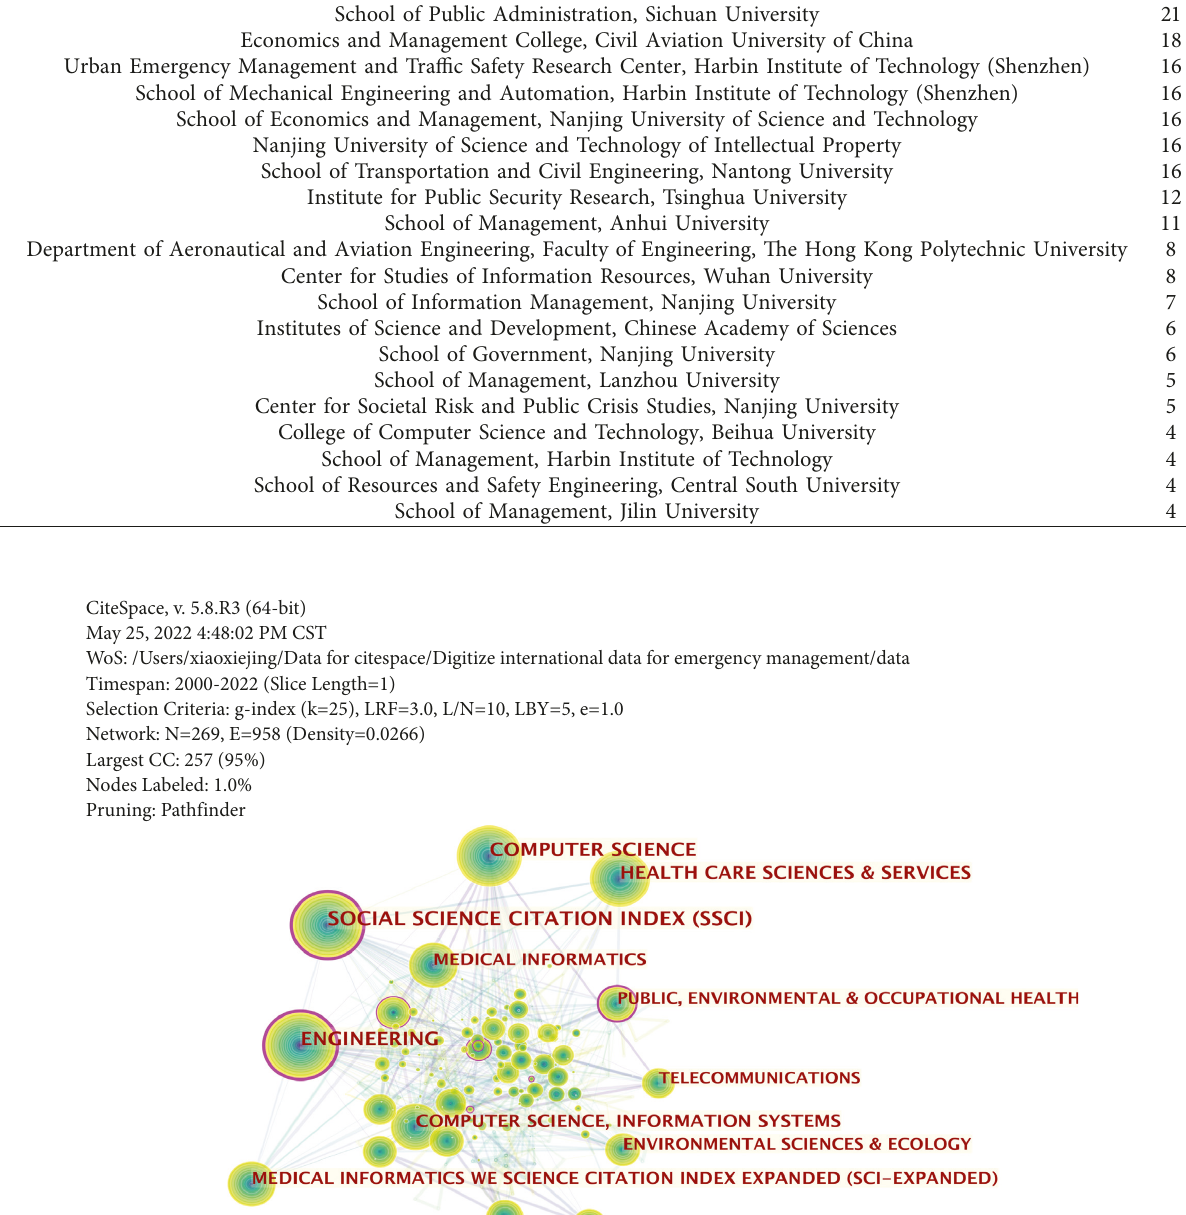
Table 4: Top 20 institutions in the number of papers of Chinese DEM research. Rank